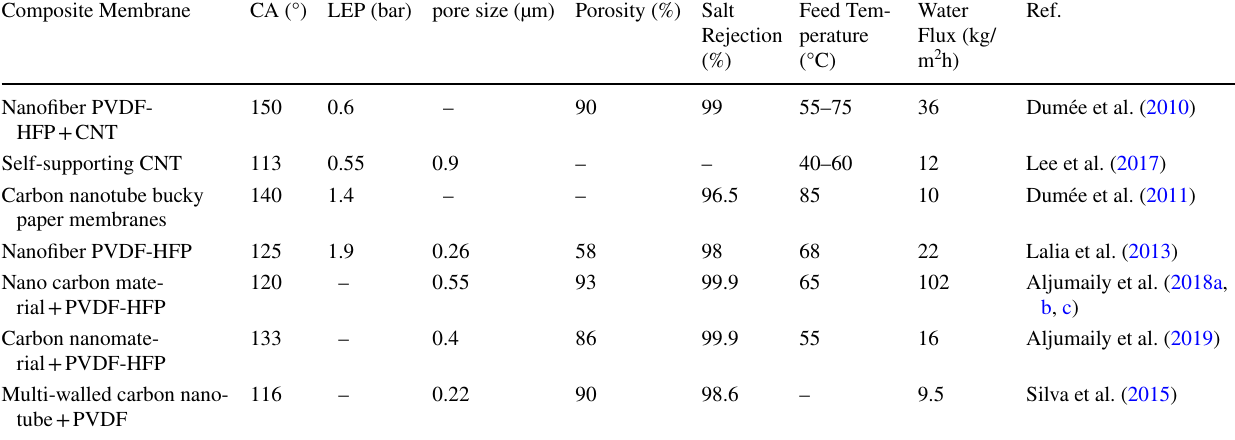
Table 2 DCMD flux in the present study and that reported in selected literature for carbon nanomaterial membranes Composite Membrane